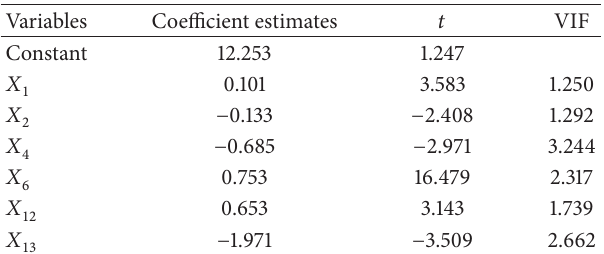
Table 3: The results of parameter estimates using three selection procedures.